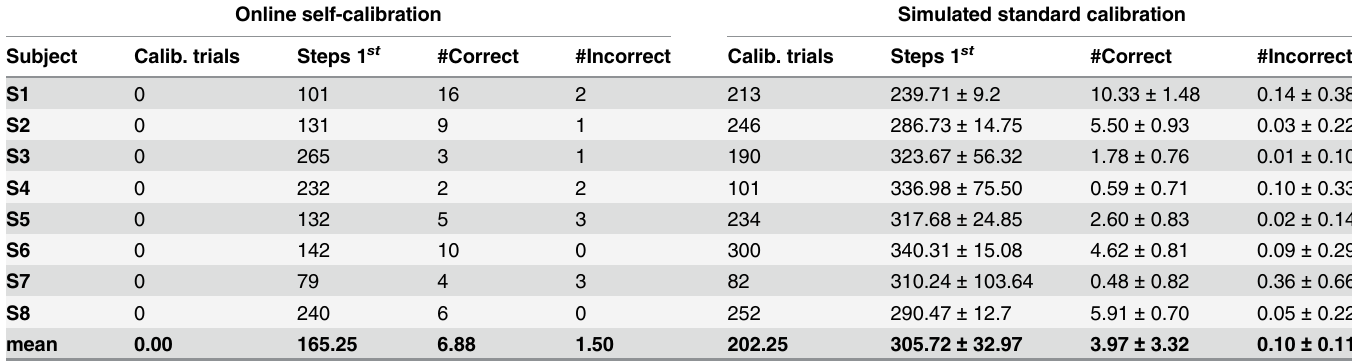
Table 1. Task results.